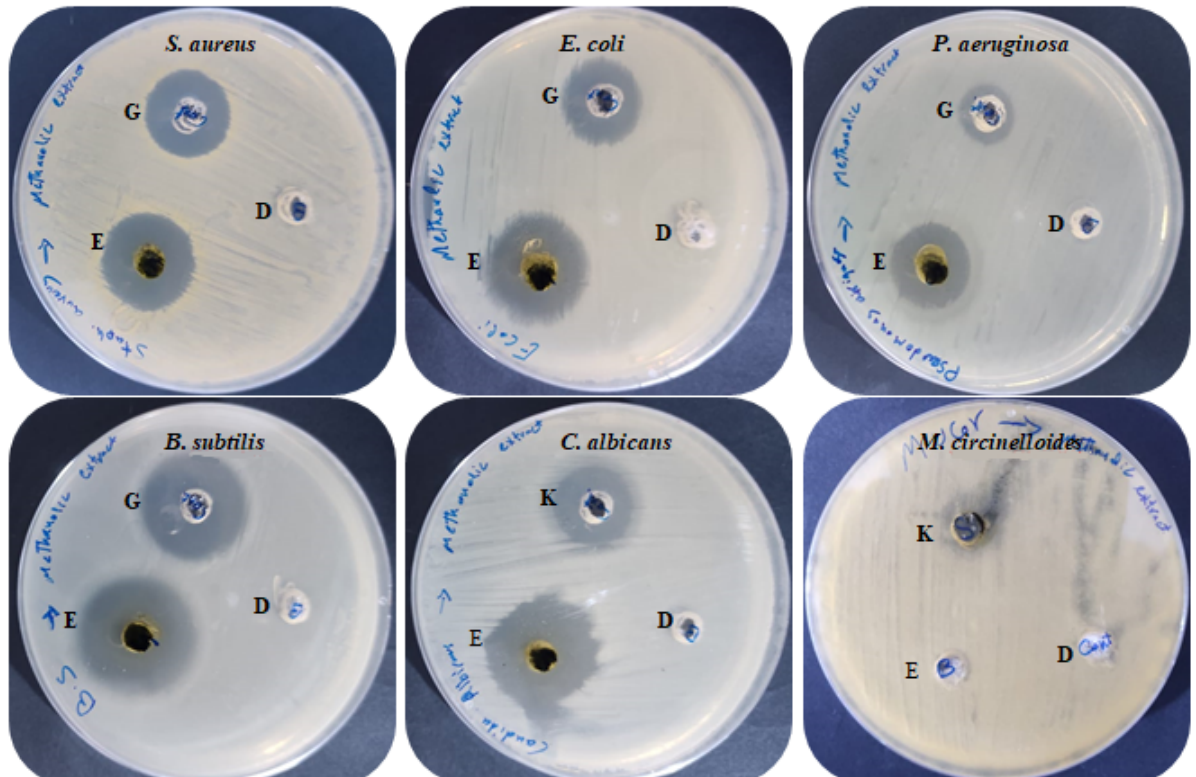
Figure 5. Antimicrobial activities of M. pulegium extract against different bacteria and fungi: (E) M. pulegium extract; (D) methanolic loaded disc, (G) Gentamycin, (K) Ketoconazole. TEM of untreated and treated S. aureus and P. aeruginosa with M. pulegium extract are shown in Figure 6. The untreated cells of S. aureus had a distinct structure with cocci shape and intact cellular walls, and showed no signs of damage or morphological change (Figure 6A). Some deformations were observed in S. aureus treated by M. pulegium extract (Figure 6B,C), including partially digested cell wall and exfoliated fragments from the surface of bacterial cell, exposition of the patches in the cytoplasmic membrane, lack of cell wall or its detachment from the membrane, thickening of the outer membrane, and abnormal septa with the presence of ghost cells. Toxic effects of the M. pulegium extract on the structure and function of the membrane have generally been used to describe the antimicrobial action of the extract and its components. Untreated P. aeruginosa cells revealed a normal rod-shaped structure with an intact outer membrane and the cytoplasmic membrane near the cell wall, and the intracellular content was well-maintained. The periplasmic area was narrow and homogenous (Figure 6D). Several alterations in cell shape were detected after treatment with M. pulegium extract, and the periplasmic space indicated separation of the cell wall from the plasma membrane. The internal structures were disordered, and the components of the bacterial cell membrane were distorted and distributed from their original form. Draining of the intracellular contents was seen at particular sites within the cells, mostly at the septal and polar regions, due to breaches of the cell membrane. There were numerous cells without membranes and null cells of P. aeruginosa (Figure 6E,F). Approximately the same alteration was recorded in P. aeruginosa , leading to cell death